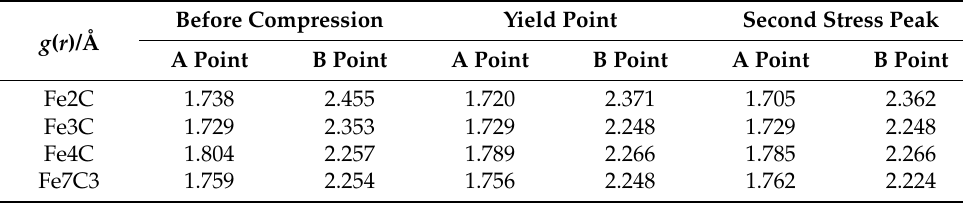
Figure 9. Radial distribution function between iron and carbon atoms ( a ) Fe2C, ( b ) Fe3C, ( c ) Fe4C, ( d ) Fe7C3. Table 7. Output results of interatomic bond length at two peaks.